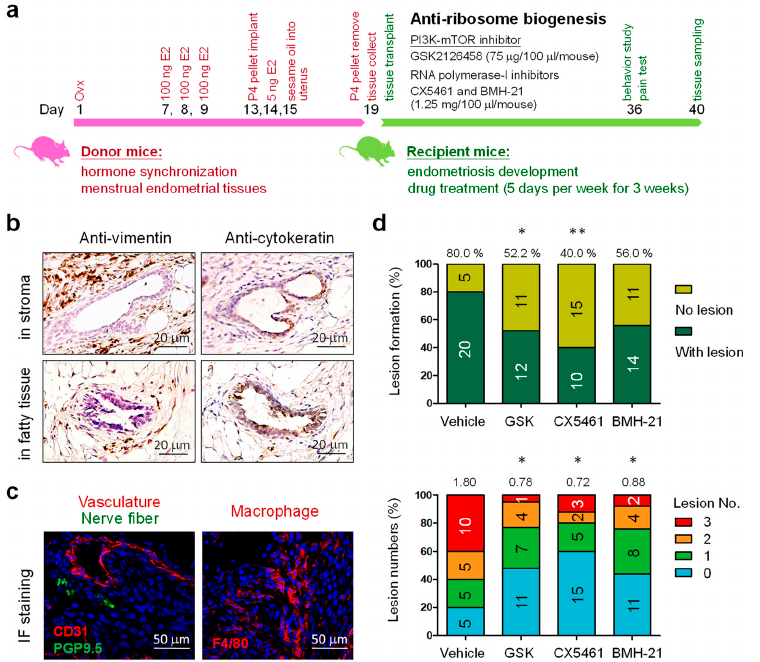
Figure 1. Anti-ribosome biogenesis treatment in a mouse model of endometriosis induced in C57BL/6JNarl mice. ( a ) The schematic diagram indicates the timeline of procedures performed on donor and recipient mice. The recipient mice were further treated with GSK2126458 (GSK; n = 23), CX5461 ( n = 25) and BMH-21 ( n = 25) at the indicated drug dosages for three weeks. Vehicle-treated mice ( n = 25) were utilized as controls. ( b ) Tissue section staining revealed the presence of stroma (anti-vimentin) or glands (anti-cytokeratin) in the collected lesions. ( c ) The disease frequencies and average lesion numbers in drug-treated mice were counted and compared with that in control mice. ( d ) Statistical differences between vehicle and drug-treated groups were compared by chi-squire test. The p values were presented as *: p value < 0.05 and **: p value <